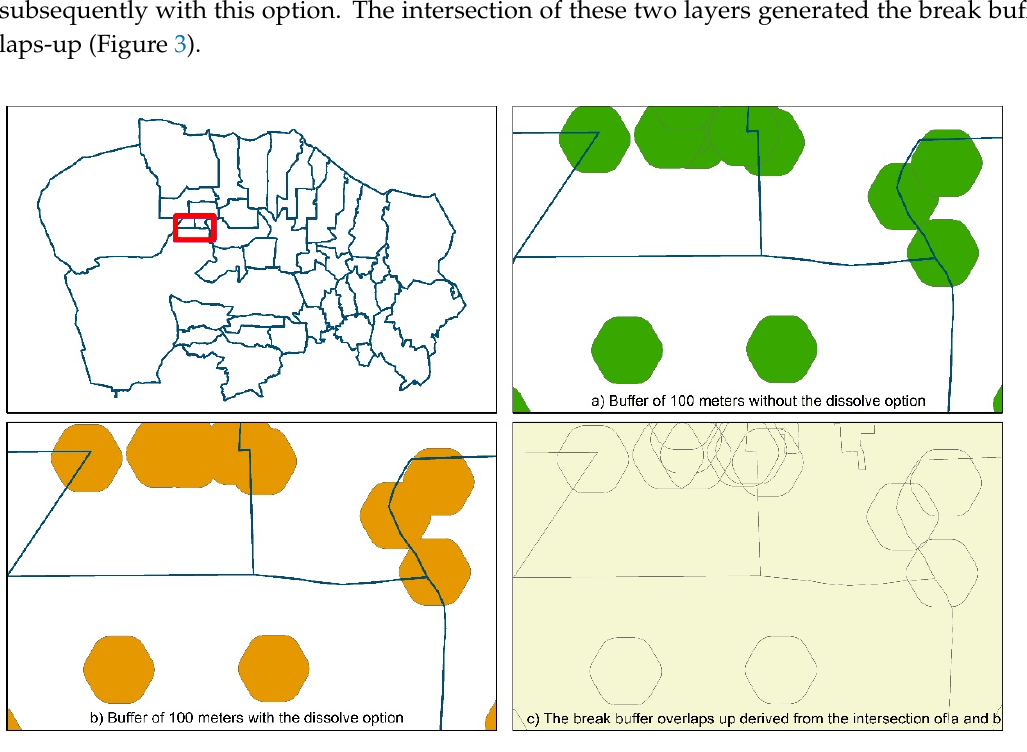
Table 2. Conversion table from alpha-numeric score to the corresponding Hazard Risk Level (HRL).